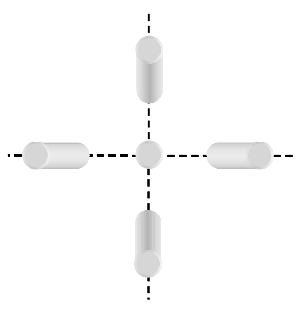
Figure 12. Location of the bottom of the detected objects.